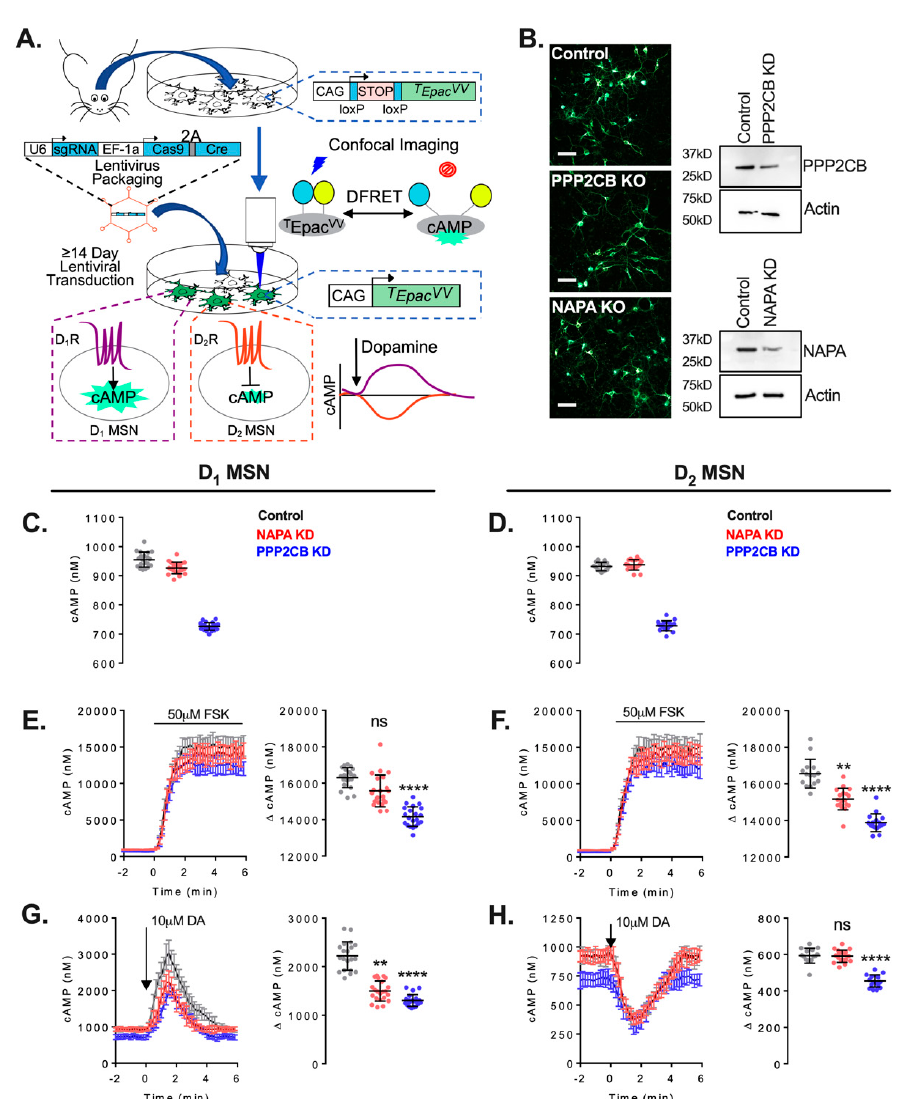
Figure 6. CRISPR / Cas9 deletion of NSF (N-ethylmaleimide-sensitive factor) attachment protein alpha (NAPA) and protein phosphatase 2A catalytic subunit (PPP2CB) reduces cAMP signaling in primary striatal neurons. ( A ) schematic of the experimental design. ( B ) ( left ) representative confocal images of CAMPER biosensor expressing neurons in DIV14 primary striatal neurons. Images are a merged stack of mTurquoise and Venus fluorescence. Scale bar equals 50 µ m. ( B ) ( right ) western blot validation